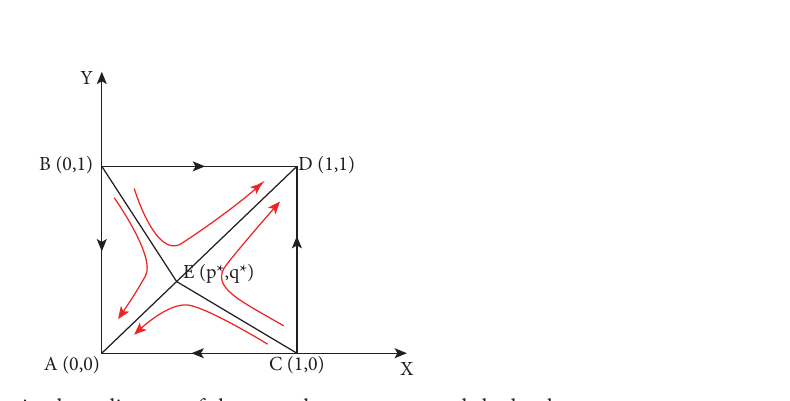
Numerical Symbols Numerical Symbols Z ∗ S